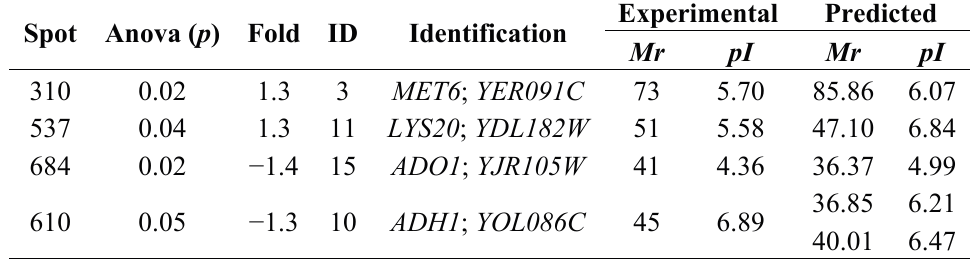
Mutant  sky1 Treated versus Untreated Spot